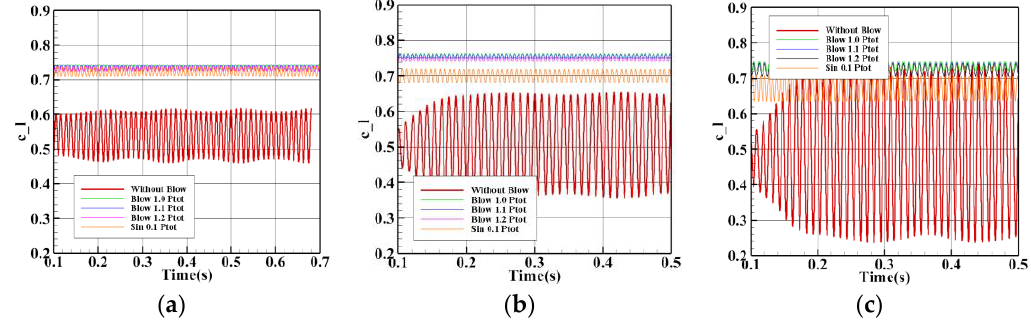
Figure 18. Unsteady lift coefficient histories under the “ 41% x/c ” case at: ( a ) 5.0°, ( b ) 5.5°, and ( c ) 6.0°.